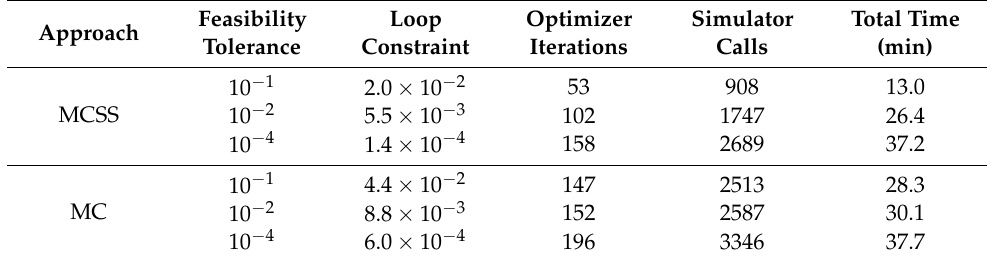
Table 7. Comparison between MCSS and MC: Data Reconciliation problem.